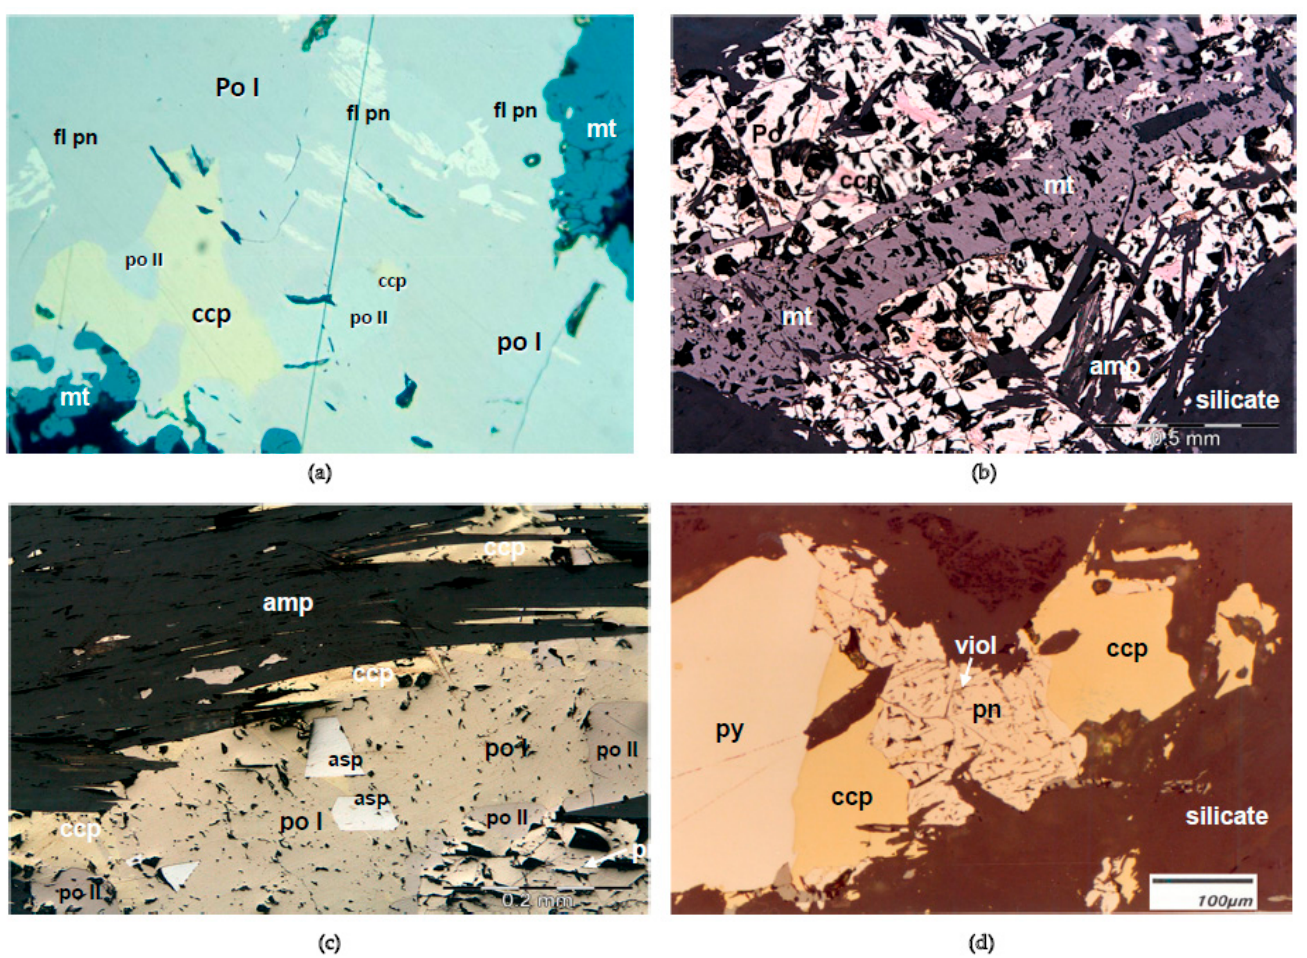
Figure A2. Plate 2. Central and upper intrusives: ( a ) MP (XPL) of talc-chlorite-rich sheared Chro- mitiferous Harzburgite; ( b ) MP (XPL) of Main Harzburgite serpentinized (srp) olivine (ol) in ortho- pyroxene (opx) matrix with interstitial magnetite and chromite (chr); ( c ) MP (XPL) of altered Gab- bronorite amphibolitized clinopyroxene/orthopyroxene and biotite (bt) with interstitial quartz, al- bite, zircon (zr), rutile (rt); ( d ) MP (XPL) of Upper Gabbro clinopyroxene (cpx), plagioclase (pl), in- terstitial quartz (qz), and albite (ab).